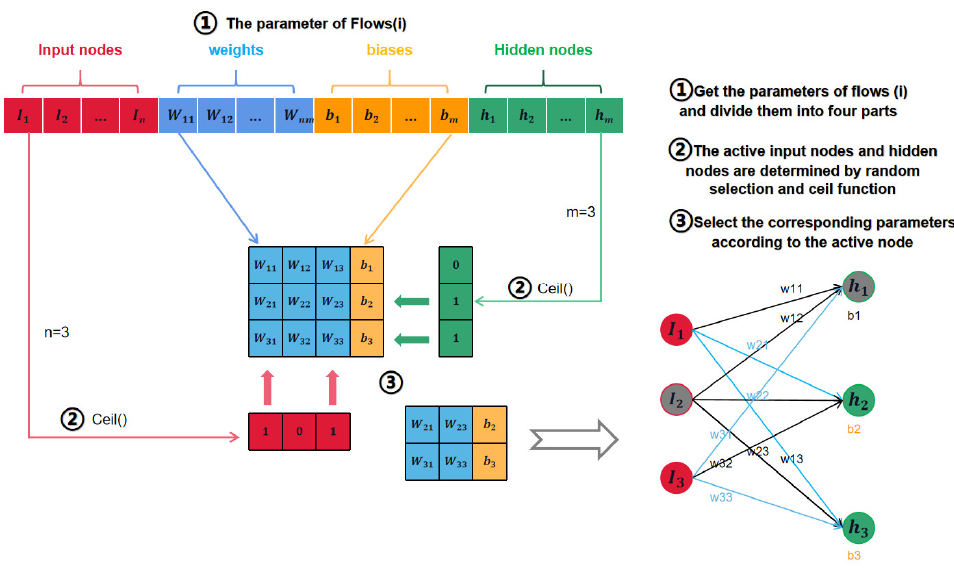
Figure 3. Search agent mapping flowchart.